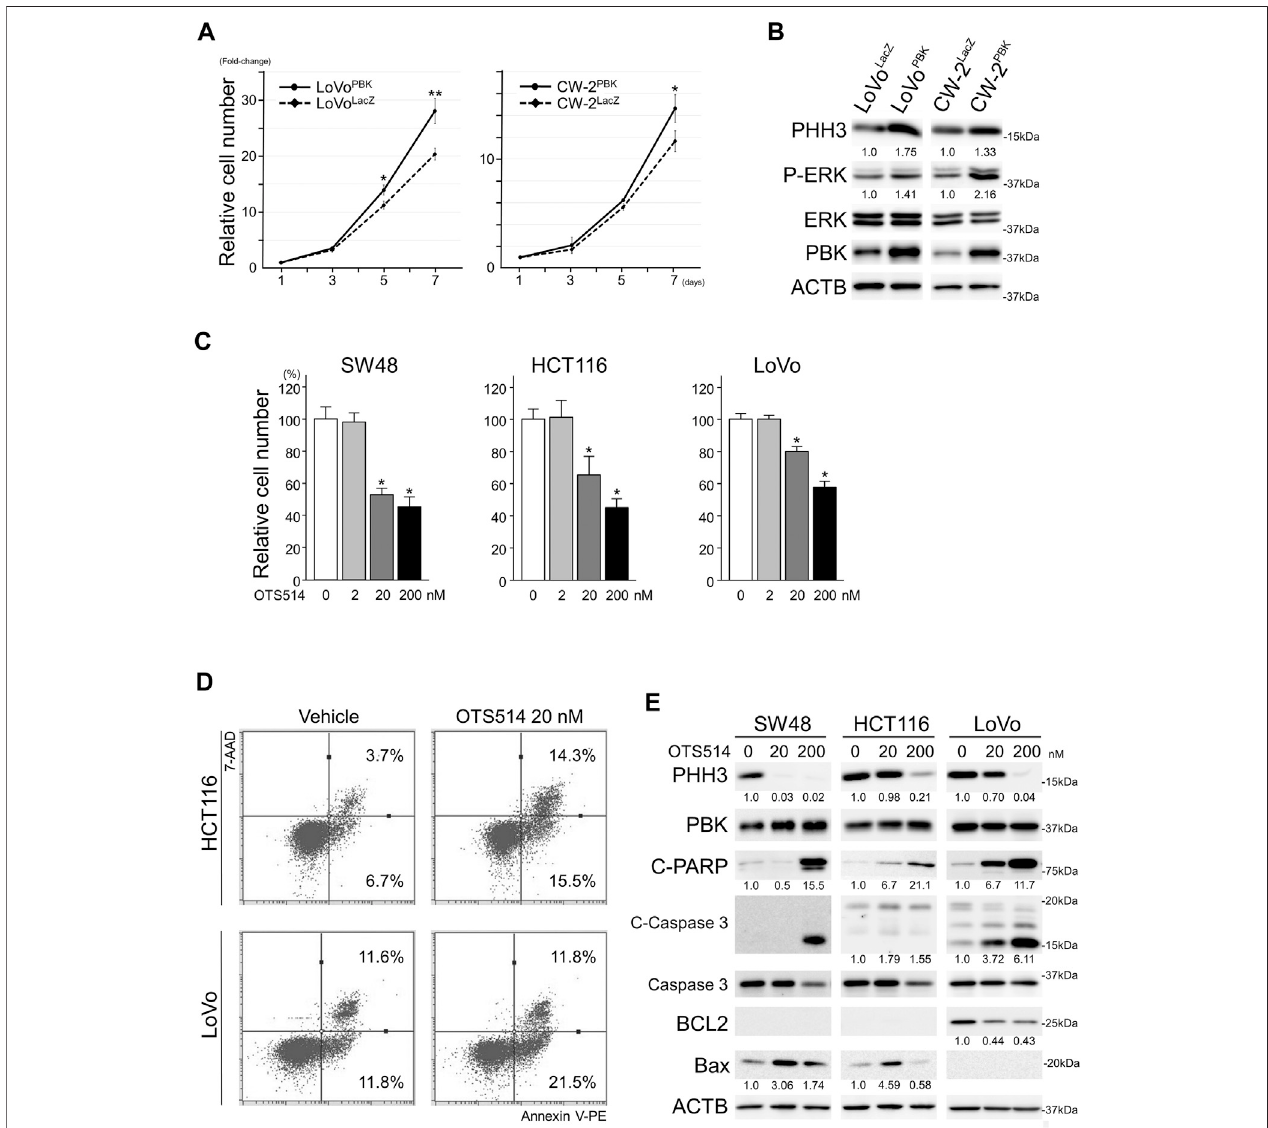
FIGURE 2 | PBK enhanced the cellular proliferation of CRC cells. (A) , exogenous PBK expression enhanced the cellular proliferation of CRC cells. Data are shown as mean ± S.D. *, p < 0.05, **, p < 0.01. (B) , immunoblot analysis showing up-regulated P-ERK and PHH3 in PBK-induced CRC cells. (C) , OTS514, a selective PBK inhibitor, suppressed the cellular proliferation of CRC cells. Data are shown as mean ± S.D. *, p < 0.05. (D) , Annexin V assay in HCT116 and LoVo cell lines showing induction of apoptosis after OTS514 treatment. (E) , protein expression of PHH3 and apoptosis-related proteins in CRC cells after OTS514 treatment. Note that